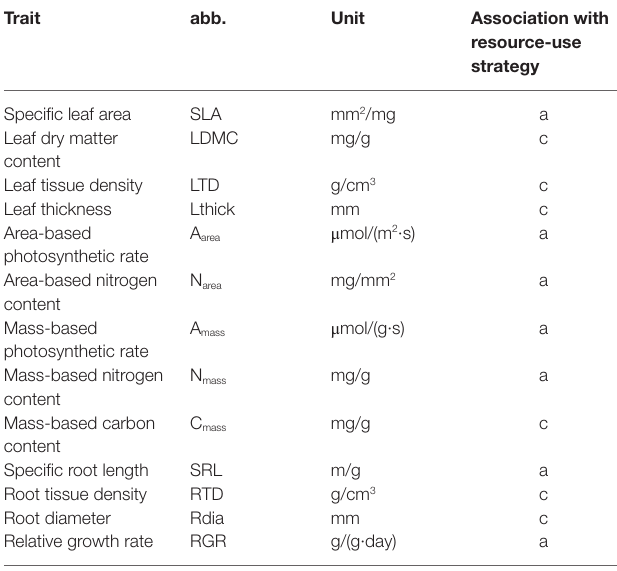
TABLE 1 | Studied resource-use related traits, and relative growth rate with their abbreviation (abb.), unit, and hypothesized association with the resource-use strategy according to the plant economics